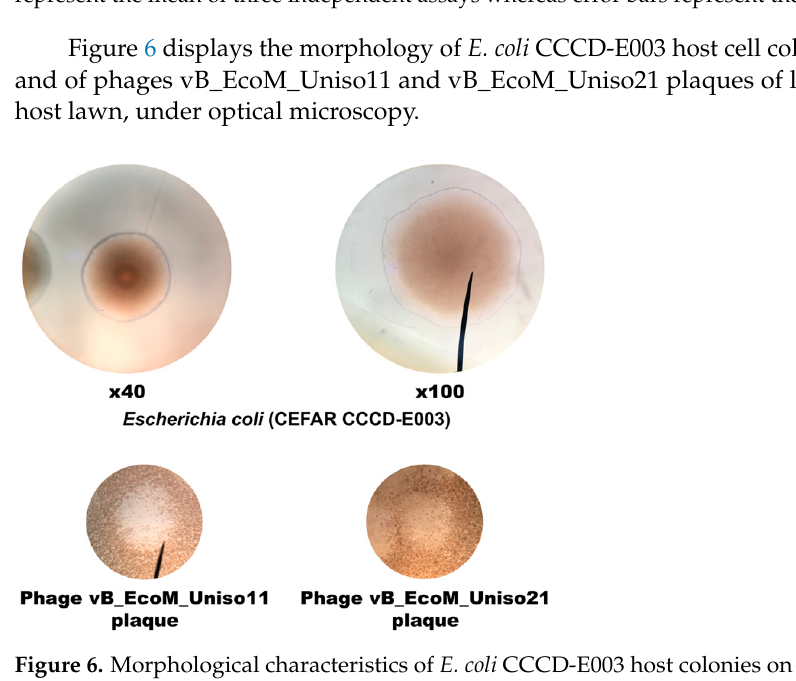
Figure 5. Ex vivo inactivation of E. coli in artificially contaminated canine uterus by phage cocktail at MOI values of 10 and 100, during 12 h. ( a ) Bacterial concentration: BC, bacterial control; BP-B, bacteria with phage; ( b ) phage concentration: PC, phage control; BP-P, bacteria with phage. Values represent the mean of three independent assays whereas error bars represent the standard deviation.